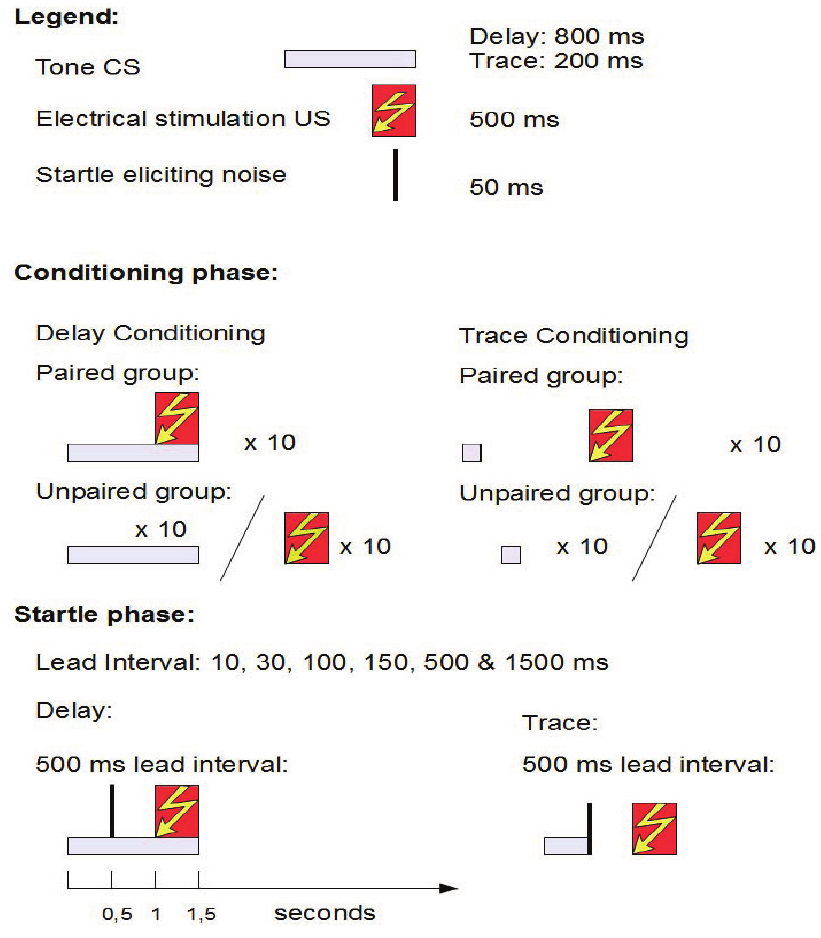
Figure 5. A schematic presentation of the structure of experiment the experiment in